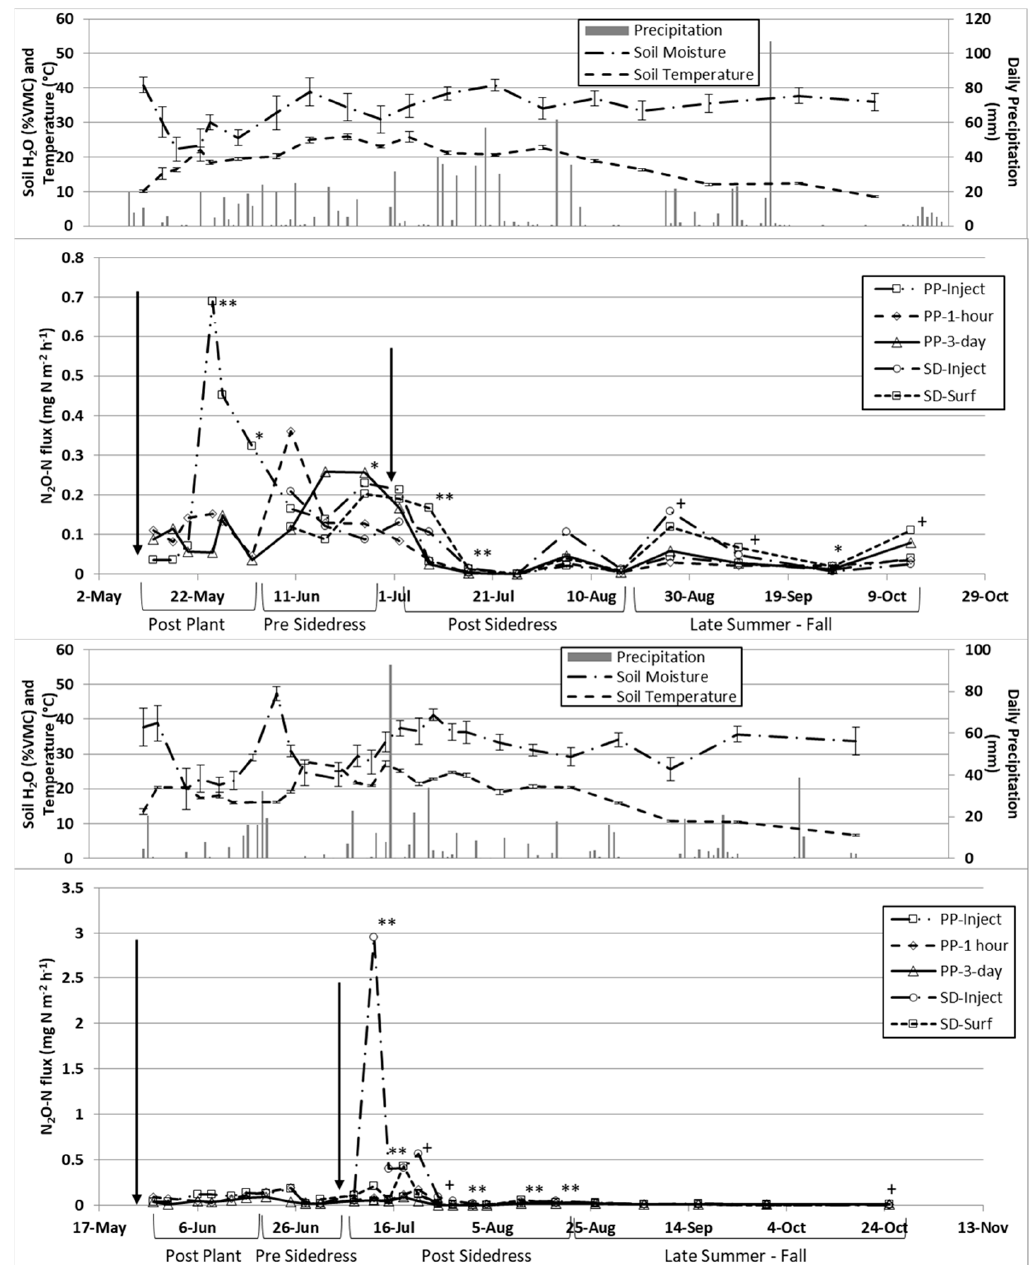
Figure 3. Nitrous oxide (N 2 O-N) fluxes (mg N m − 2 h − 1 ) and associated soil temperature and moisture content for 2010 (top two panels) and 2011 (bottom two panels). Means differing among treatments within a sampling date are denoted as follows: ** p = 0.01; * p = 0.05; + p = 0.10. There were no significant differences in annual cumulative N 2 O emission in